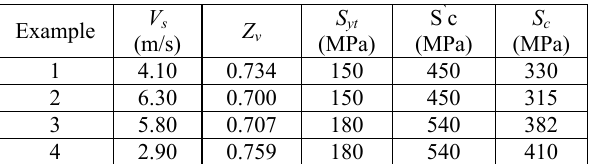
Table C1: Service Pitting Strength Examples